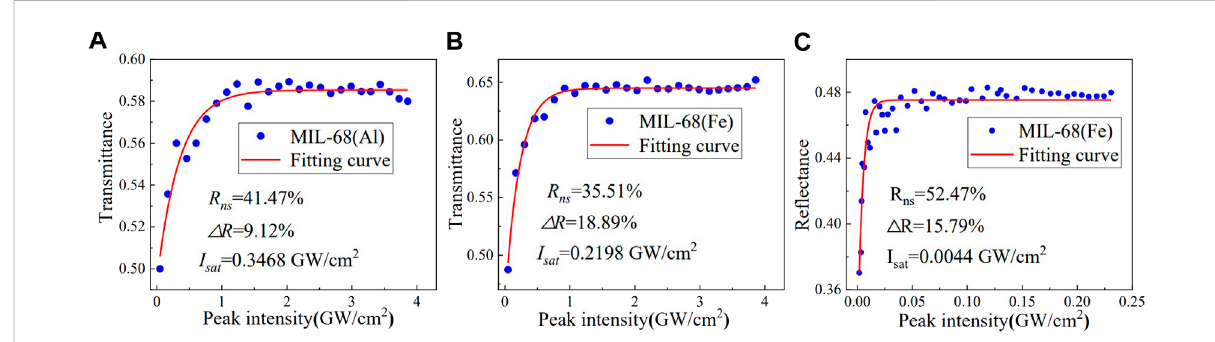
FIGURE 4 Transmittanceandre fl ectanceofthesamplesasafunctionofpulsepeakintensity. (A) MIL-68(Al)at1.99 μ m; (B) MIL-68(Fe)at1.99 μ m; (C) MIL- 68(Fe) at 2.87 μ